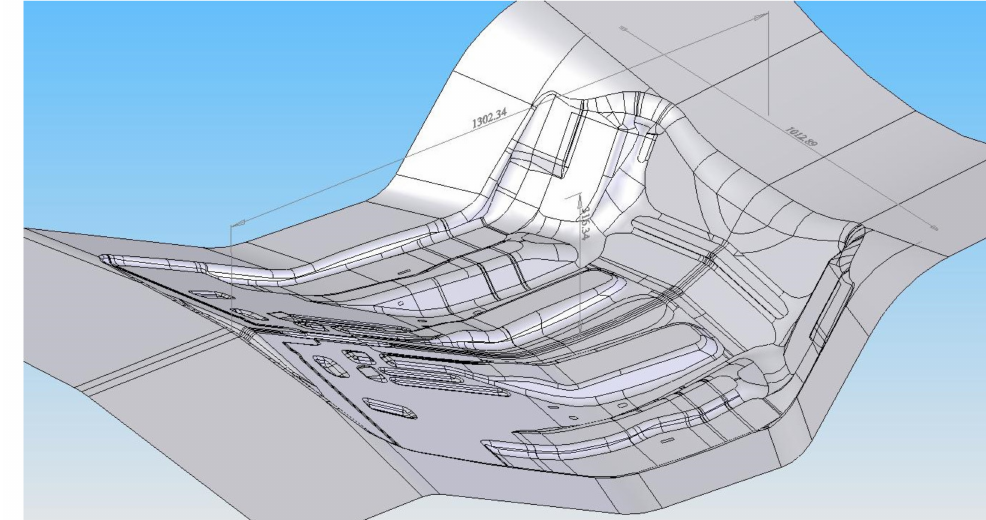
Figure 8. Design of the part for the prototype process.